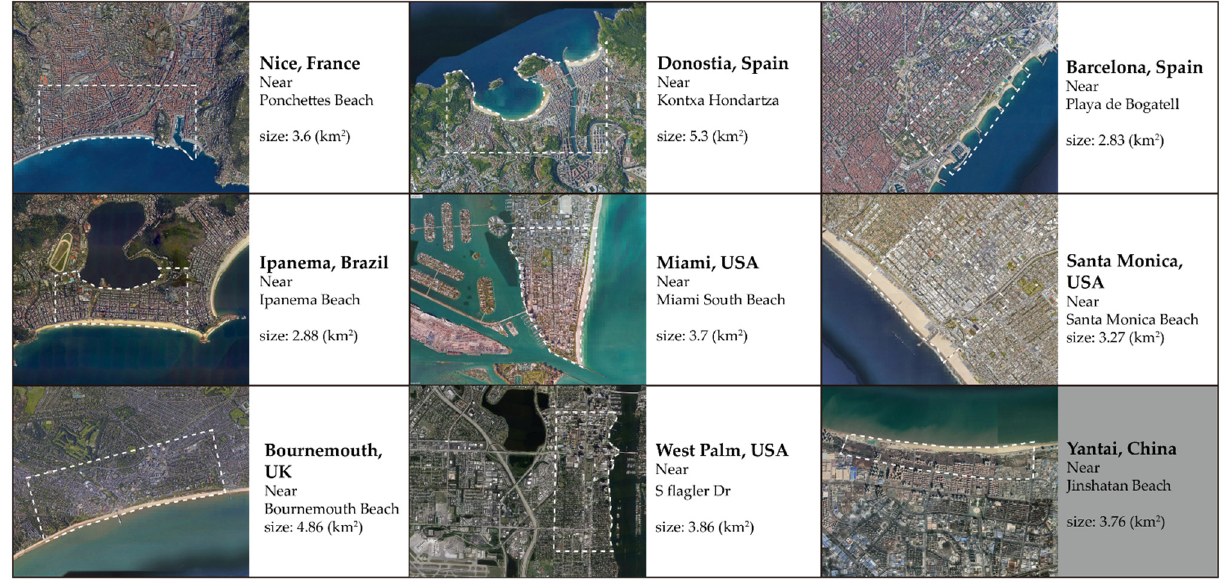
Figure 2. The waterfront areas selected by the vibrant coastal cases and the Jinshatan